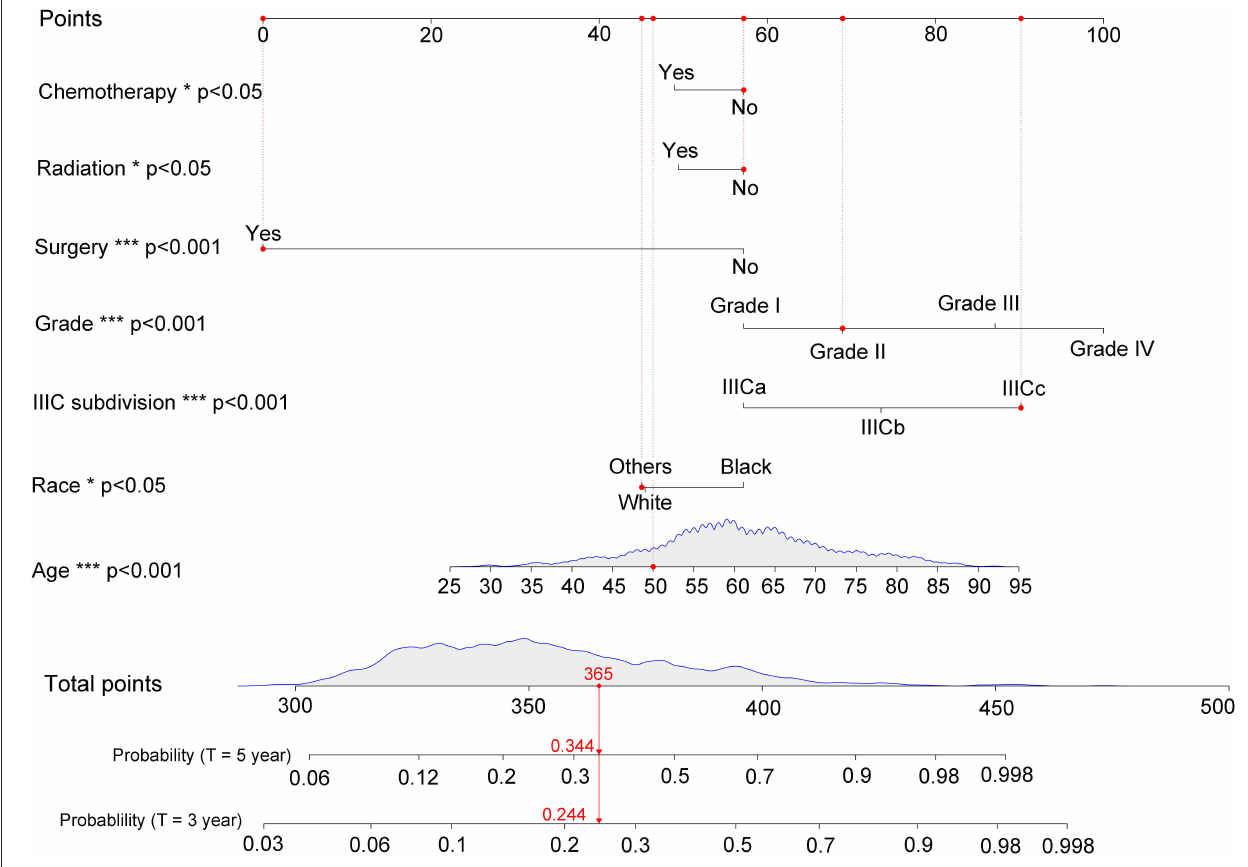
FIGURE 3 | Nomogram for predicting 3- and 5-years cancer-specific mortality with IIIC endometrioid carcinoma. The detailed scores for a randomly selected patient were represented using the red dashed line and font. IIICa consists of patients with T1N1 or T1N2; IIICb consists of patients with T2N1 or T2N2; IIICc consists of patients with T3N1 or T3N2. * p < 0.05, ** p < 0.01, and *** p <